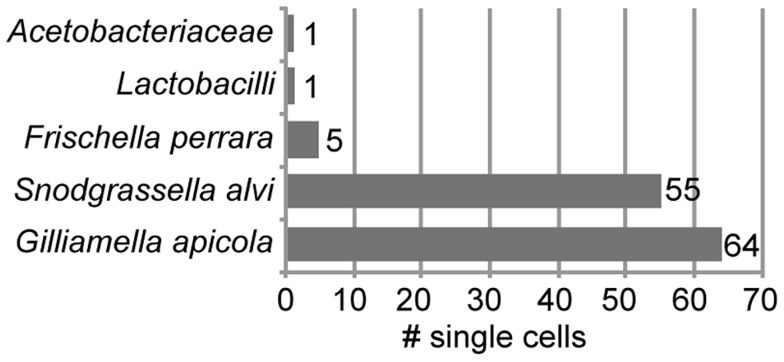
Taxonomic classification of 126 bacterial cells sorted from midguts and ileums of honey bees.Classification is based on best BLASTN hit of partial 16S rRNA sequences. Table S1 provides a complete list of all best BLASTN hits.